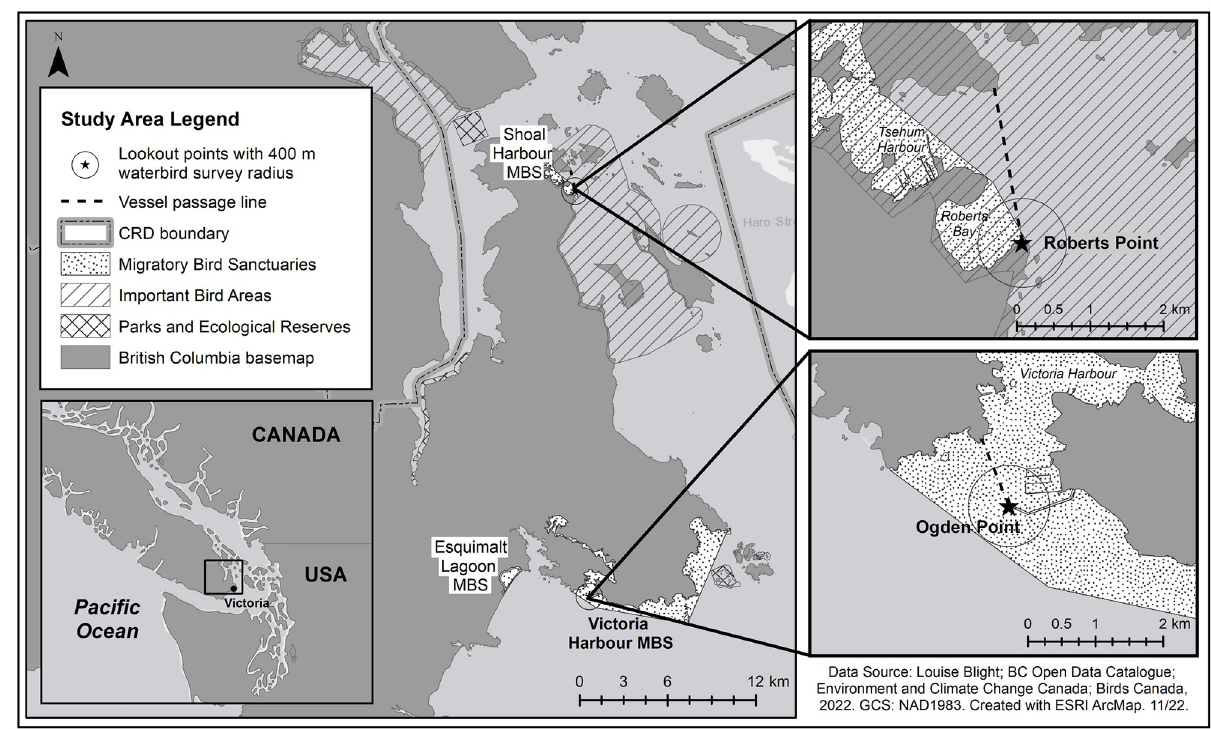
Fig 1. Study areas (Victoria Harbour and Shoal Harbour Migratory Bird Sanctuaries, Capital Regional District (CRD), Canada) showing spatial conservation designations, viewpoints, and passage lines (see text for details). Map generated by Alexandra King, Environment and Climate Change Canada. For the data source of Birds Canada (2022), listed in the figure, see [14].